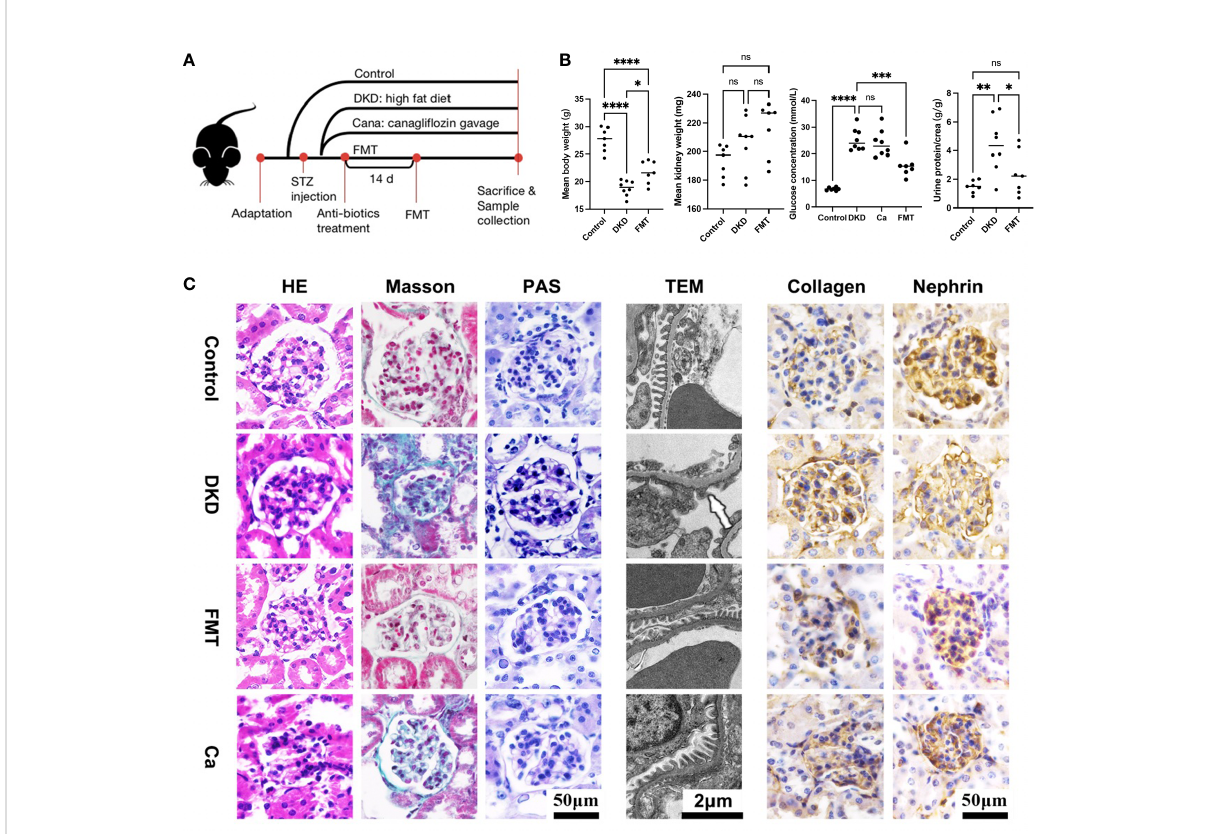
FIGURE 6 Clinical phenotyping and pathological features of mouse models. Flow chart of mouse experiment (A) . Scatter plots showed the body weight, mean kidney weight,serum glucose concentration and urine protein to creatinine ratio of each group at the end of the experiment (B) . HE, Masson and PAS staining of glomeruli in each group and EM showed detailed pathological changes in each group (C) . FMT, fecal microbiota transplantation; STZ, streptozotocin; Ca, Canagli fl ozin; HE, hematoxylin-eosin staining; PAS, periodic acid-schiff staining; EM, electron microscopy. *p<0.05; **p<0.01; ***p<0.001; ****p<0.0001. ns, no signi fi